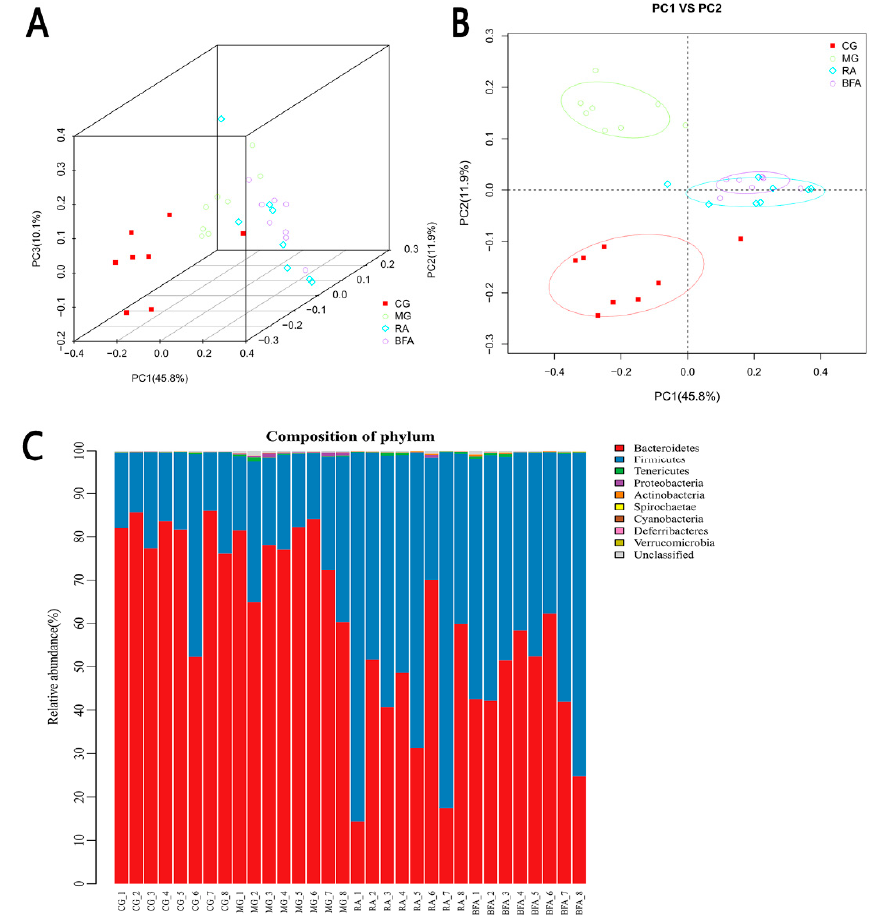
Figure 4. Comparison of the intestinal microbiota among diverse groups: ( A ) A 3D plot of the Principal Co-ordinates Analysis (PCoA) for the weighted UniFrac distance metric in intestinal microbial communities among diverse groups. ( B ) Principal Component (PC) 1 VS PC 2 of PCoA. ( C ) Histogram of bacterial flora distribution at the phylum level in each sample. Species that could not be annotated were classified into the ‘unclassified’ category. Differences were assessed by ANOVA.